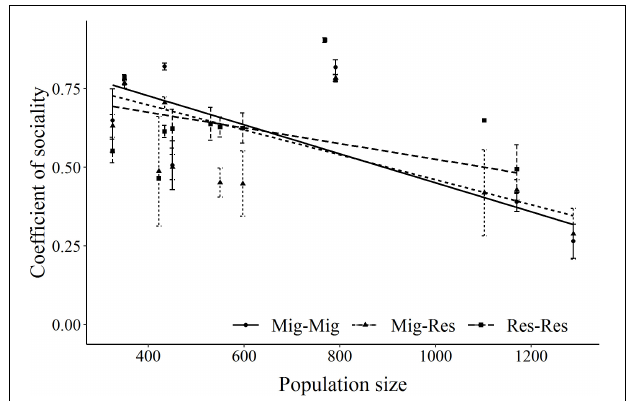
FIGURE 6 | Relationship between the coefficient of sociality of GPS-collared elk dyads by migrant-migrant (Mig_Mig, circle, solid line), migrant and resident (Mig_Res, triangle, dotted line) and resident and resident (Res_Res, square, dashed line) dyad type on Ya Ha Tinda winter range adjacent to Banff National Park, Alberta, Canada, during winters from 2002–2003 to 2015–2016. Error bars show ± 1 standard error. Supplementary Table S5 provides model